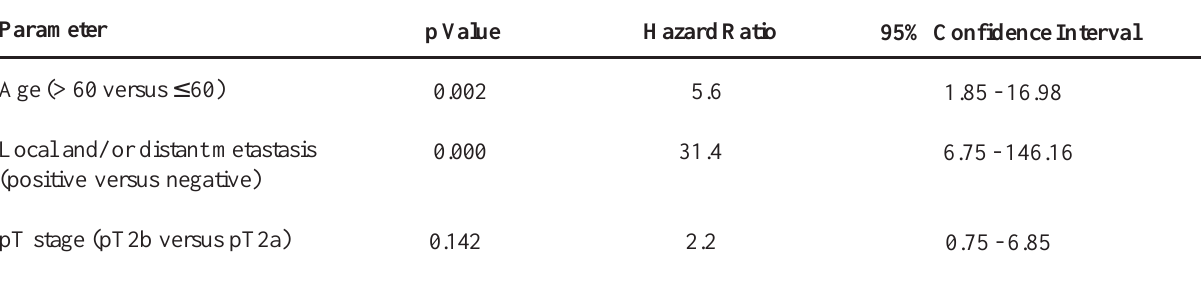
Table 2 – Association of various variables with survival for patients with T2 bladder cancer on multivariate analysis.